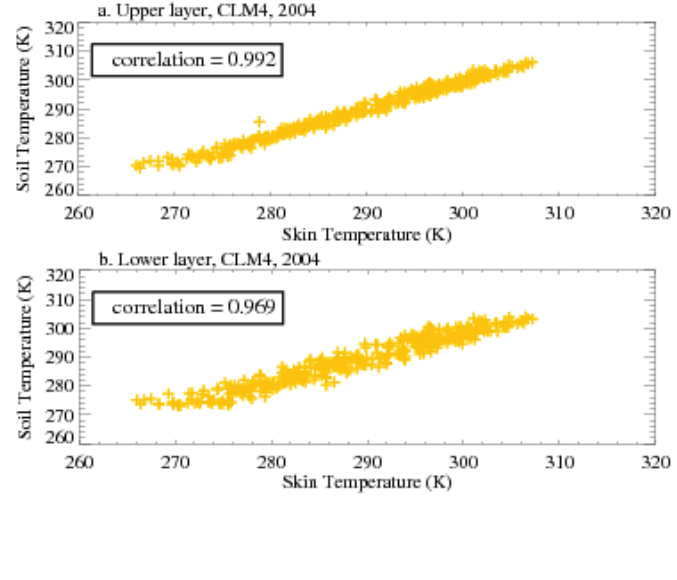
Figure 8. Same as Figure 3, except that skin temperature and soil moisture are from offline CLM4 ARM-forced run for daily averaged value in Year 2004, ( a ) the upper soil layer ( − 0.05 m) and ( b ) the lower soil layer ( − 0.25